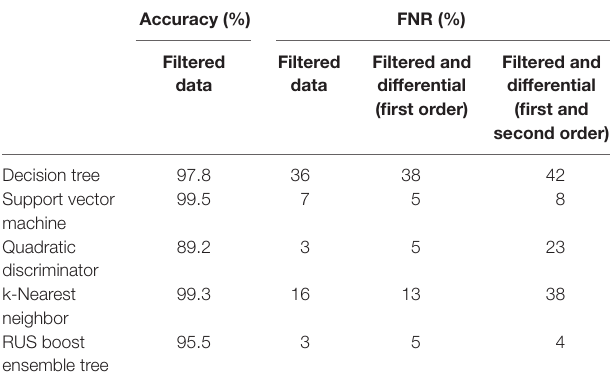
TaBle 5 | Model accuracy and false negative rates (Fnrs) for classifiers and data feature type.